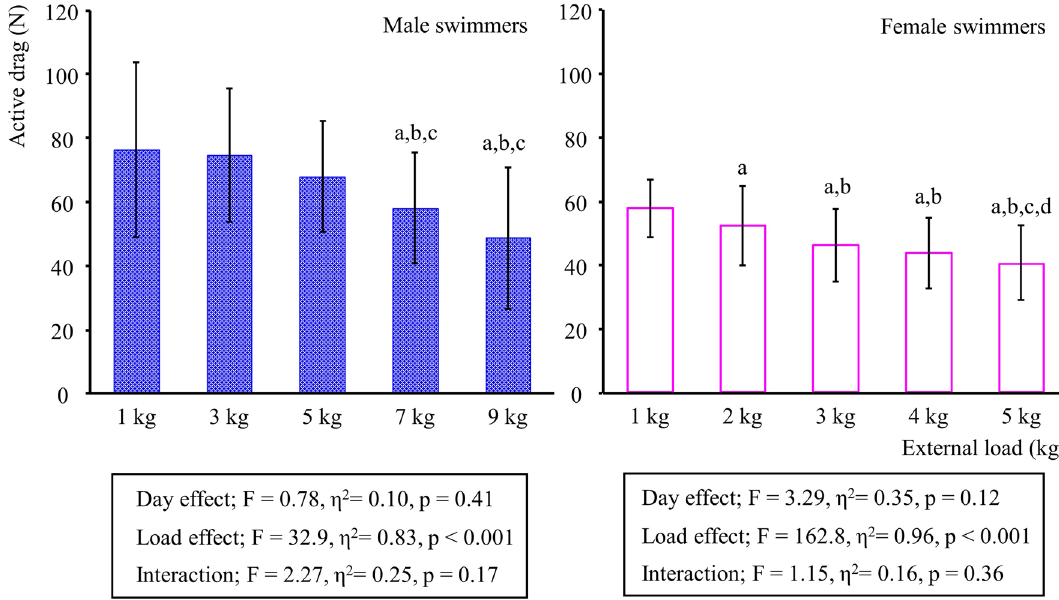
Figure 1. Active drag estimated from different external loads with results from a two-way repeated-measures ANOVA. Due to the non-significant day effect, the mean active drag between the two testing days is presented in the figure. Vertical bars are the standard deviation, and a, b, c and d show a significant difference from 1, 3, 5 and 7 kg (males) or 1, 2, 3, 4 kg trials (females),